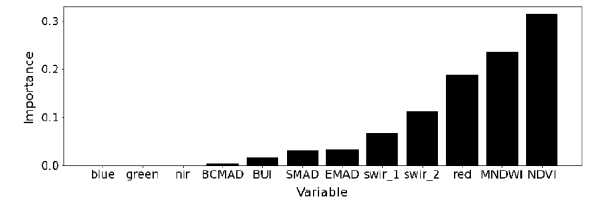
Figure 6. Bands in order of importance.